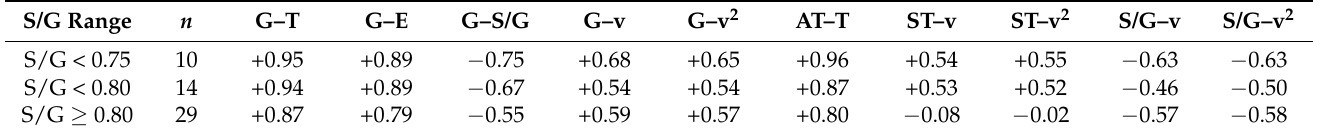
Table 8. Correlation coefficients between monthly mean parameters and/or terms for three S/G conditions during June 2013 to December